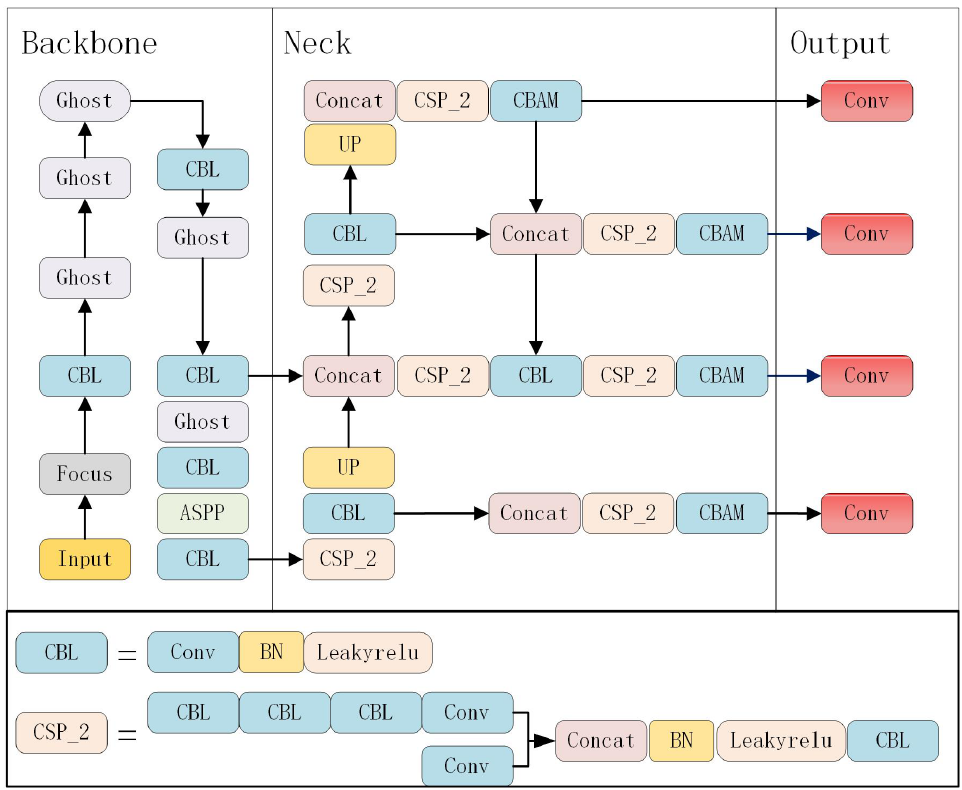
Figure 4. The structure diagram of the improved YOLOv5s model with ASPP (Atrous Convolutional pyramidal pooling) added to the backbone network, CBAM (fused attention mechanism) introduced at the neck end, and a detection scale added at the prediction